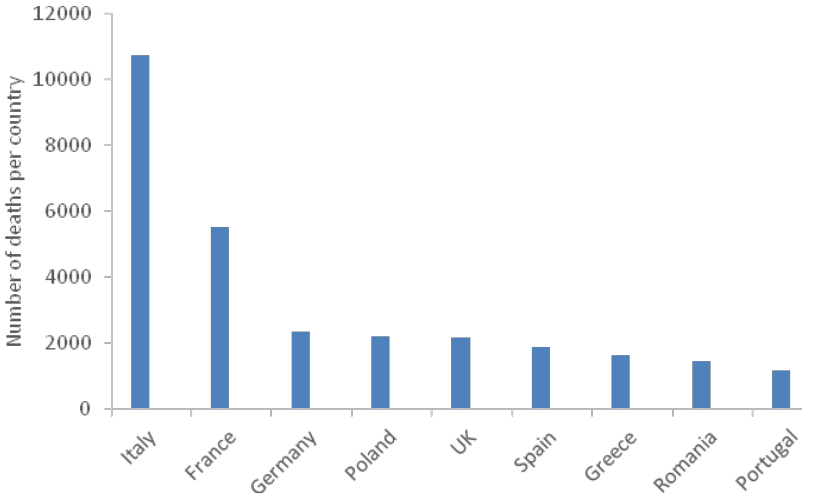
Figure 2. Number of deaths caused by antibiotic-resistant bacteria by EU country. Adapted from [4].